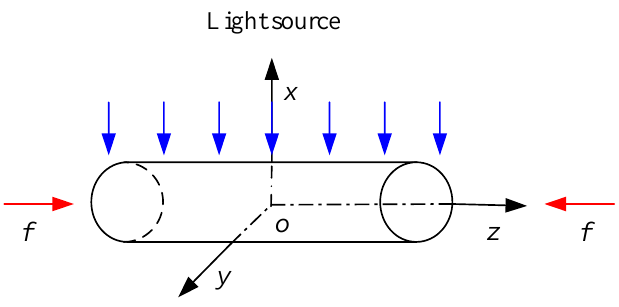
Figure 2. The physical model of ultraviolet irradiation on a GaN